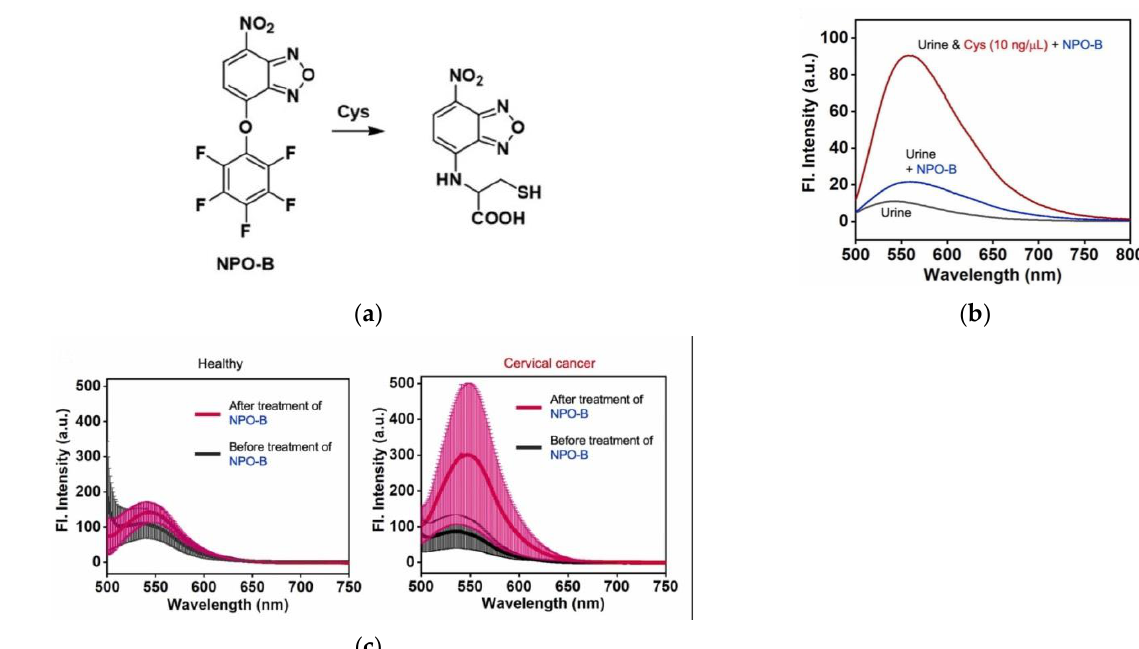
Figure 26. ( a ) Mechanism of the NPO-B activation by Cys; ( b ) Fluorescence spectra of NPO-B; ( c ) Fluorescence spectra of healthy urine and cervical cancer urine. Reproduced with permission from [107]. Copyright 2022 Elsevier